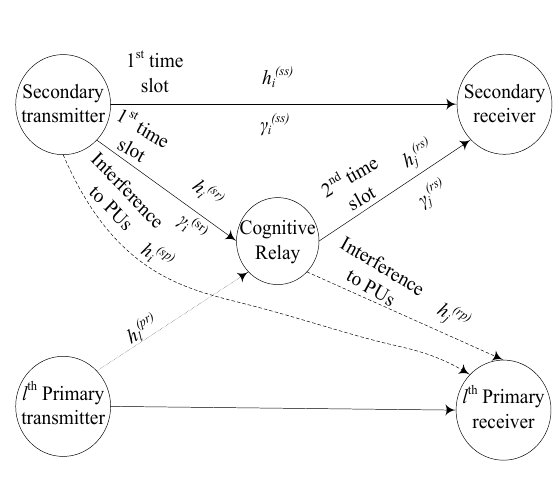
Figure 1. System Model of the CRN in Two Time Slot